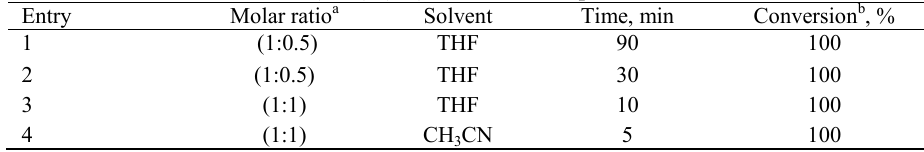
Table 1. Optimization Reaction Conditions of Reduction of Benzaldehyde